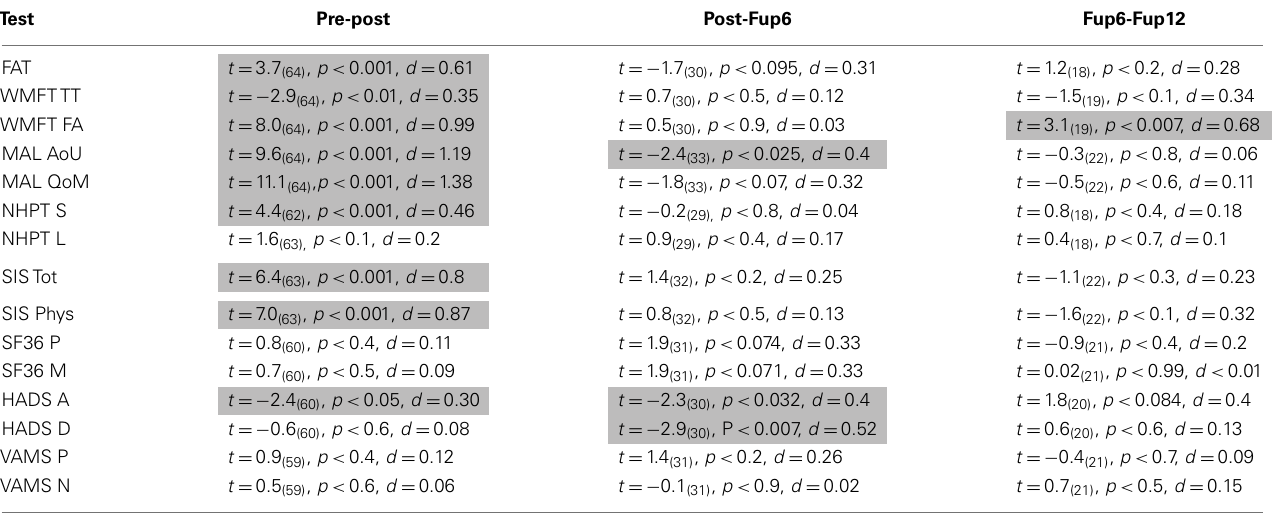
Table 2 | Summary table for whole-group analysis statistics